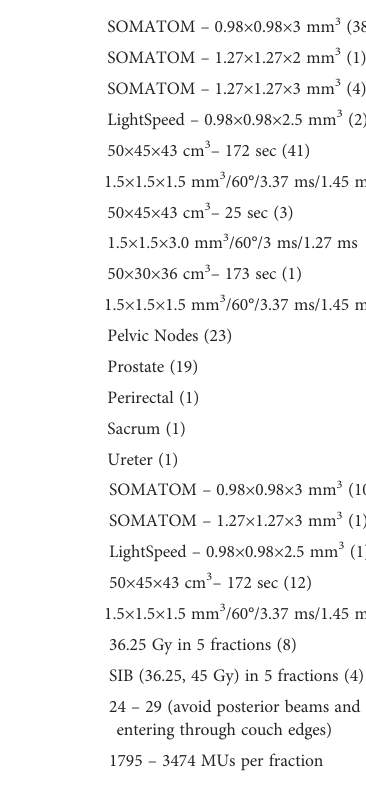
TABLE 1 CT imaging parameters (simulator model and voxel size), MR imaging parameters ( fi eld of view, scan time, voxel size, fl ip angle, repetition time and echo time), treatment sites and clinical plan information for training and validation/testing datasets. Training Datasets